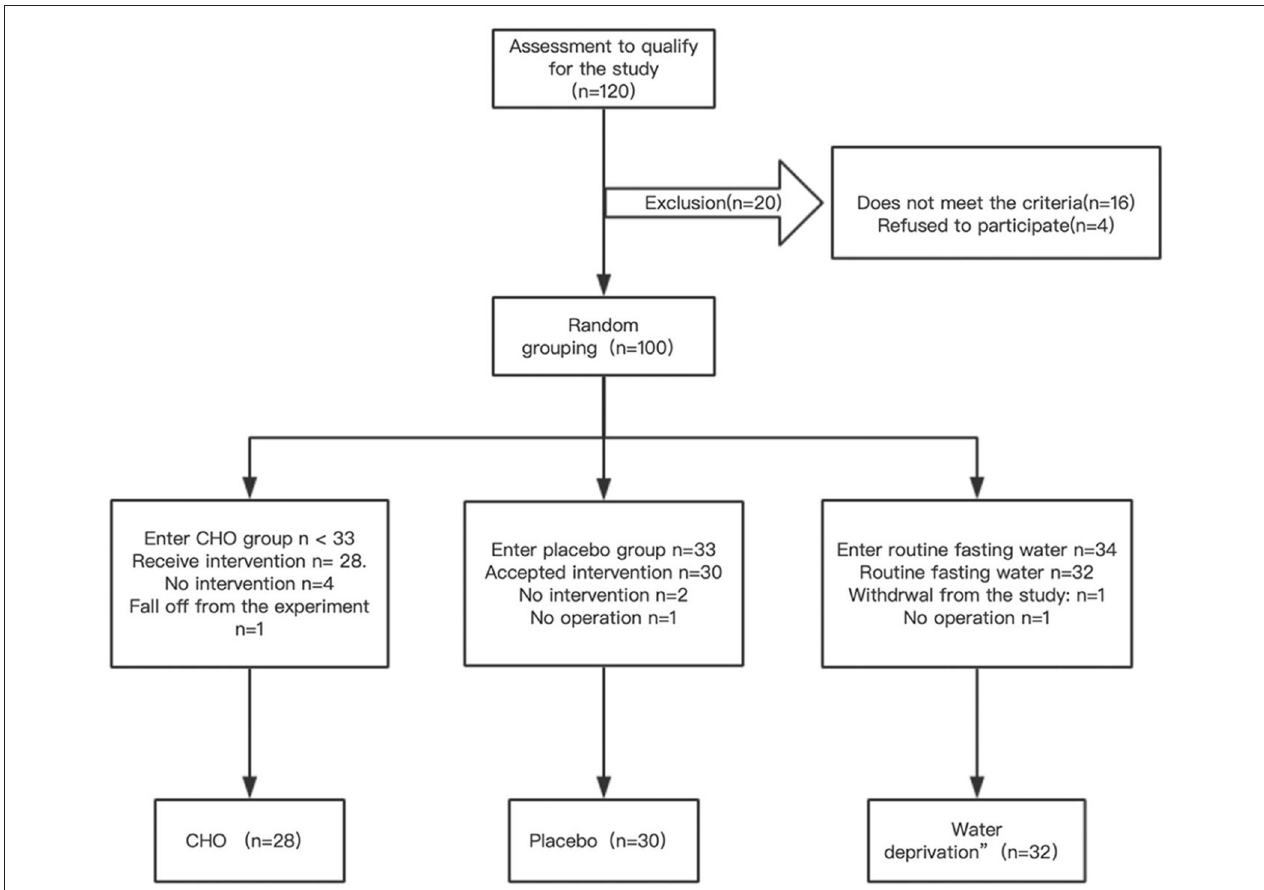
FIGURE 2 | Experimental flow